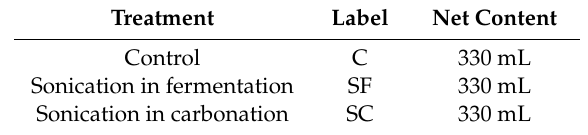
Table 1. Beer sample treatments used for the study and their labels.